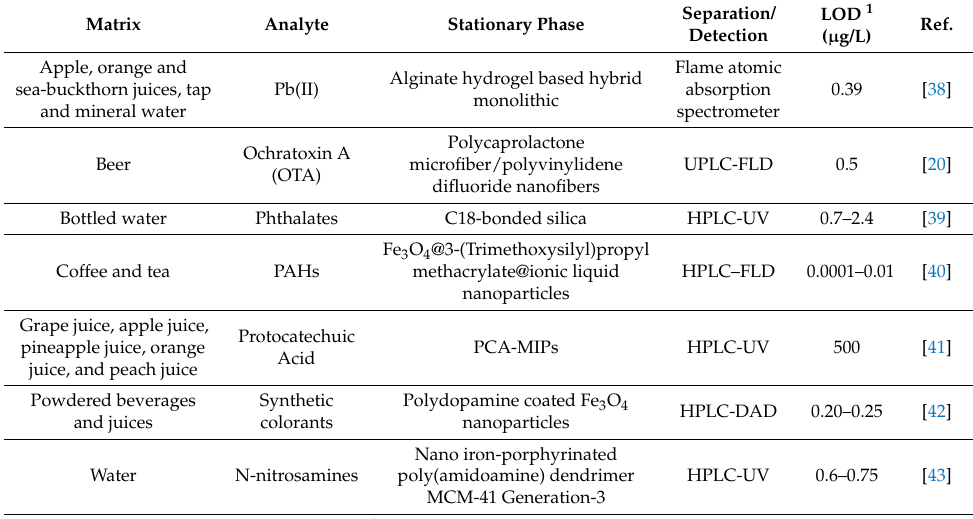
Table 1. Applications of SPE as a sample preparation technique in the analysis of